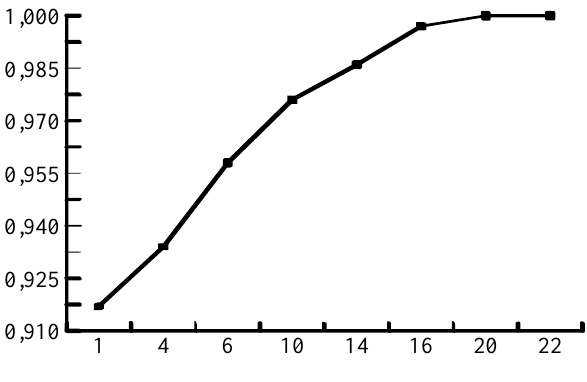
Figure. 8. A plot of the probability of correct recognition of individual flat objects on the number of standards